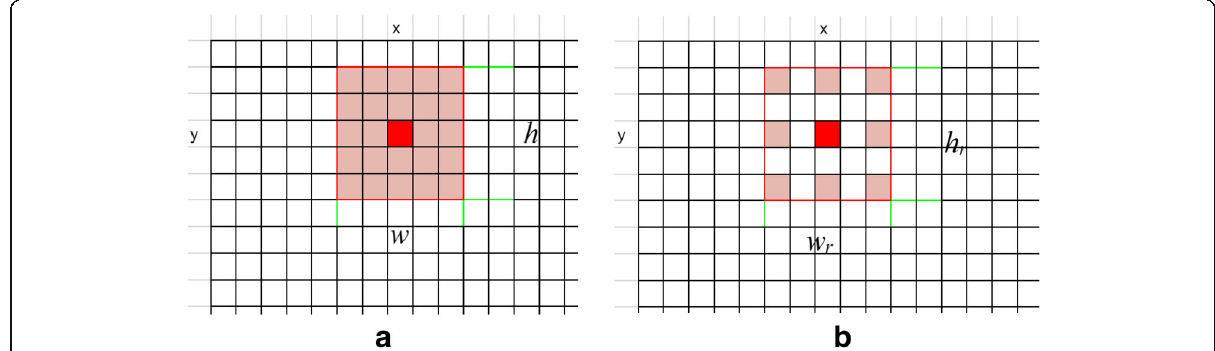
Fig. 1 Computation of kernels. a Example of a dense kernel. b Example of a sparse kernel. Each square in this figure corresponds to a value in the array that contains deltas. The red (darkest) square indicates the current position at point y , x for which a weight function value is being calculated. The frame that has several coloured squares in it is a kernel. These squares that belong to the frame, i.e. kernels, are considered when calculating the weight function value at point y ,